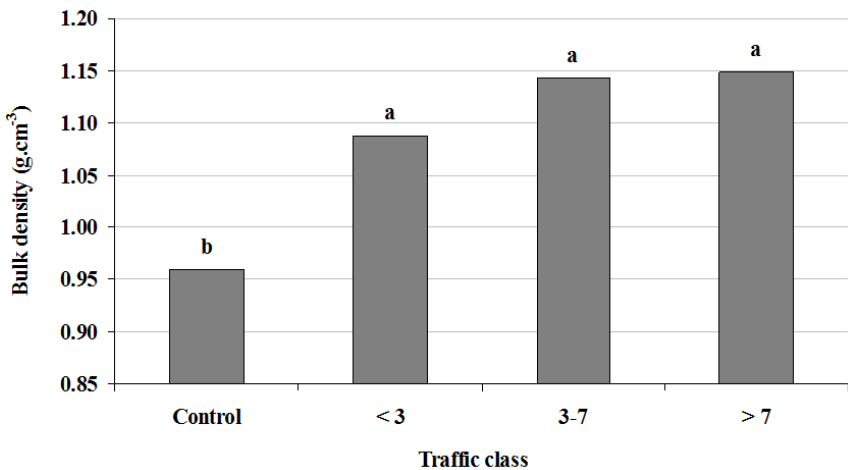
Fig. 3. Average of the bulk density in g cm –3 and its relative changes before and after skidding in each of the traffic classes using Duncan’s test (b). Different letters within each slope treat- ments shows significant differences ( p <